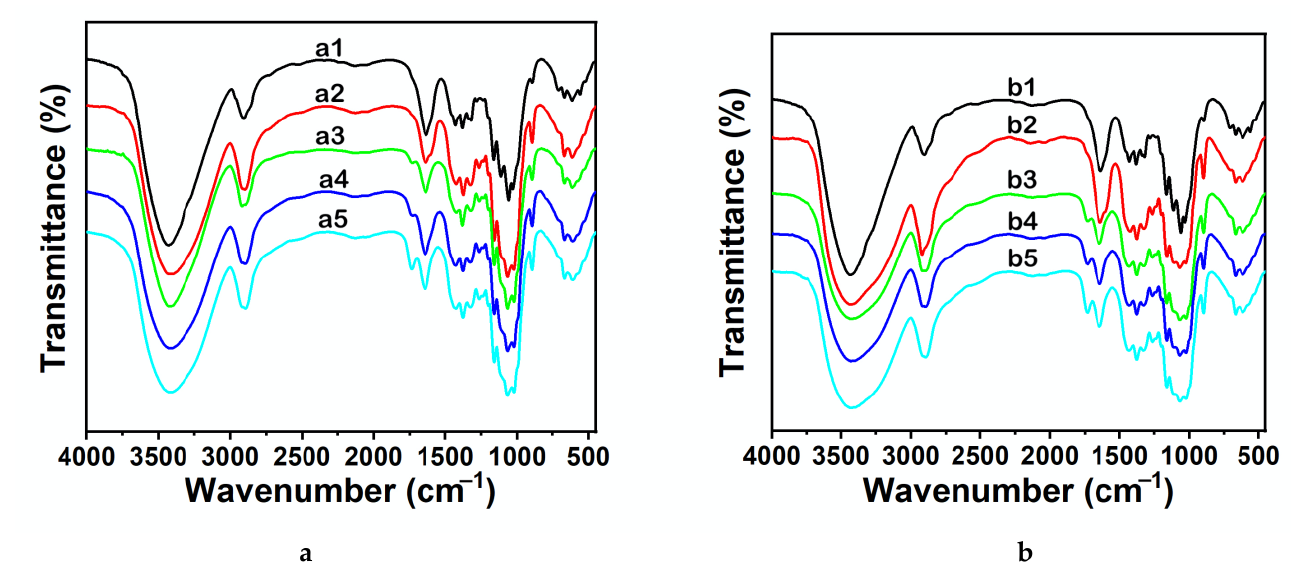
a b Figure 3. FTIR spectra of cellulose regenerated from EMIMCl solutions. The cellulose contents were 2 wt% ( a ) and 8 wt% ( b ). The antisolvent used for cellulose precipitation was either water (10 mL) at 20 °C (a2, b2, red line) or 1 equivalent of AcOH (a3, b3, green line), 2 equivalents of AcOH (a4, b4, blue line), or 3 equivalents of AcOH (a5, b5, light blue line) at 60 °C. The spectrum of MCC was included in both graphics for comparison (a1, b1, black line).